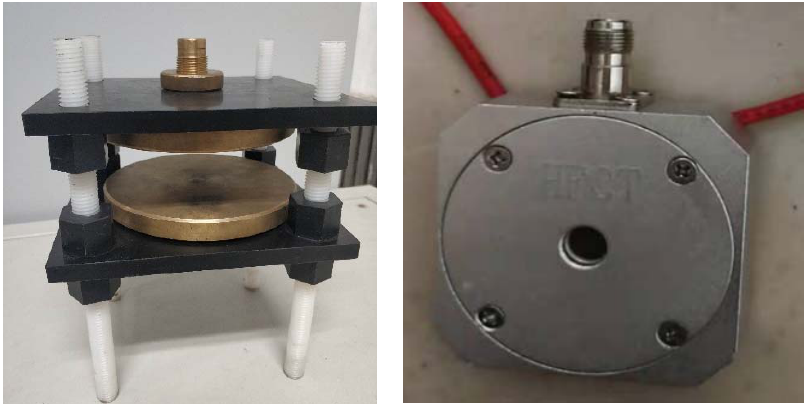
Figure 14. Schematic diagram of plate electrode partial discharge device ( left ) and HFCT sensor ( right ).